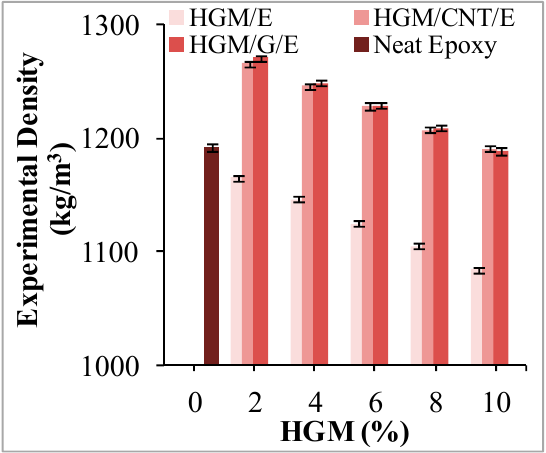
Figure 4. Experimental measured density of different composites. Table 1. Density and void content estimation of specimens.